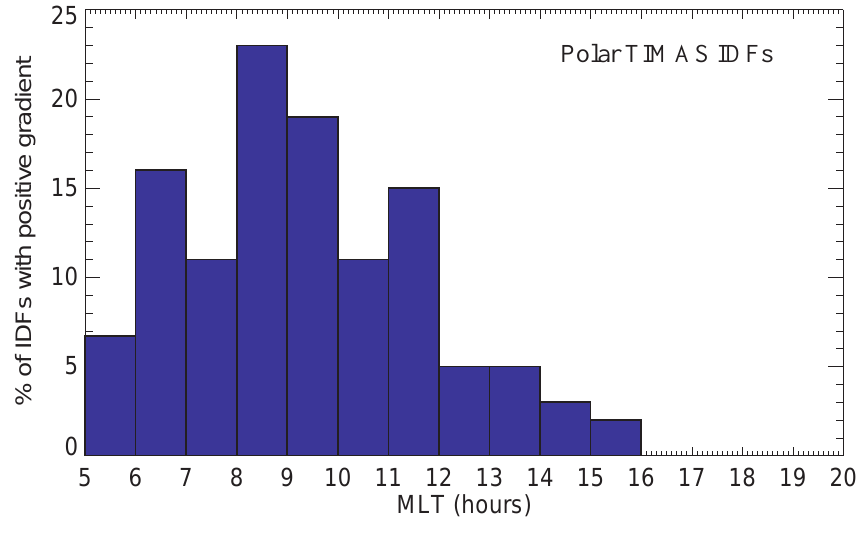
Fig. 7. Results of a statistical analysis of two years worth of Polar TIMAS data from the Tromsø L-shell. The graph indicates the percentage occurrence of IDFs that contain a similar positive gra- dient over a similar energy range to the IDF seen in the CAMMICE data in Fig. 5, as a function of magnetic local Fig. 7